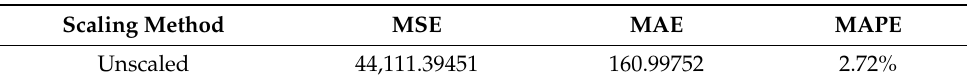
Table 1. MSE, MAE and MAPE values for the hourly load forecast. Input data are not subjected to any scaling technique.